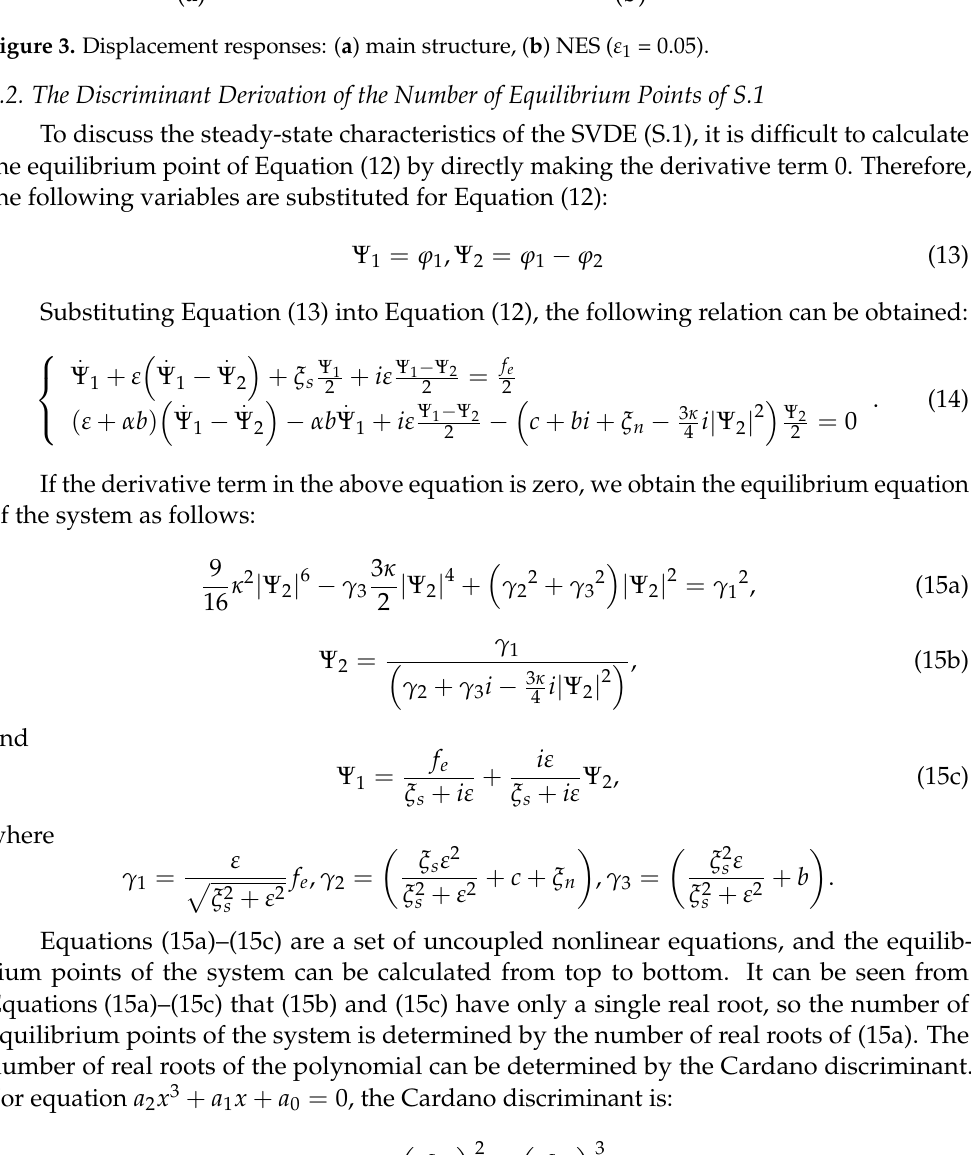
Figure 3. Displacement responses: ( a ) main structure, ( b ) NES ( ε 1 = 0.05).